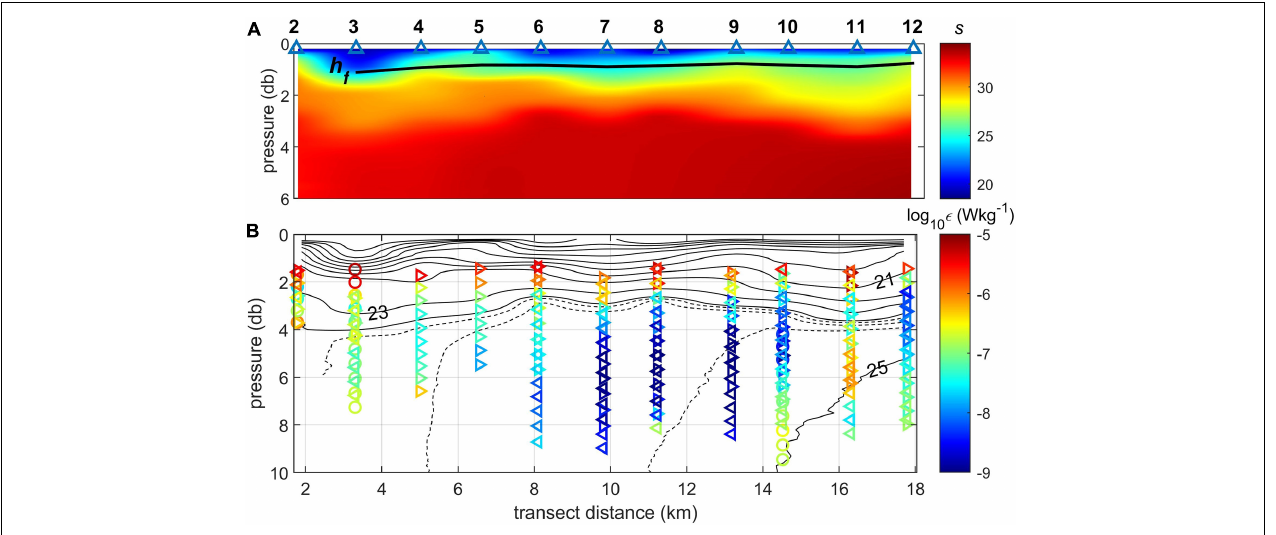
FIGURE 9 | Vertical transects derived from MicroCTD measurements, stations 2–12: (A) salinity with corresponding freshwater layer h f ; station locations are shown at the top; (B) TKE dissipation (color, different symbols represent different casts) and density σ T (black contours). Contour intervals are 1 kg m − 3 (solid line) and 0.25 kg m − 3 (dashed